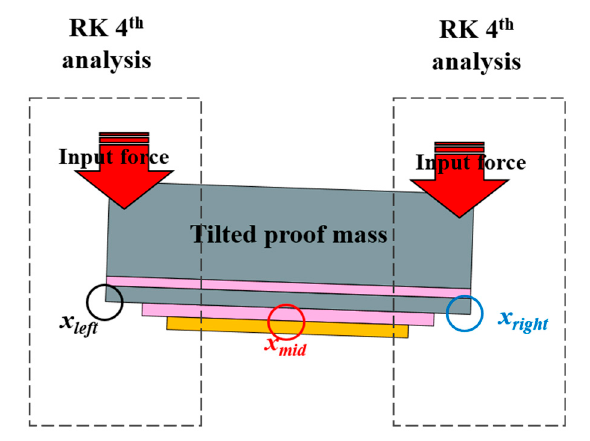
Figure 2. 2D model of the proof mass for chattering analysis using RK 4th method.